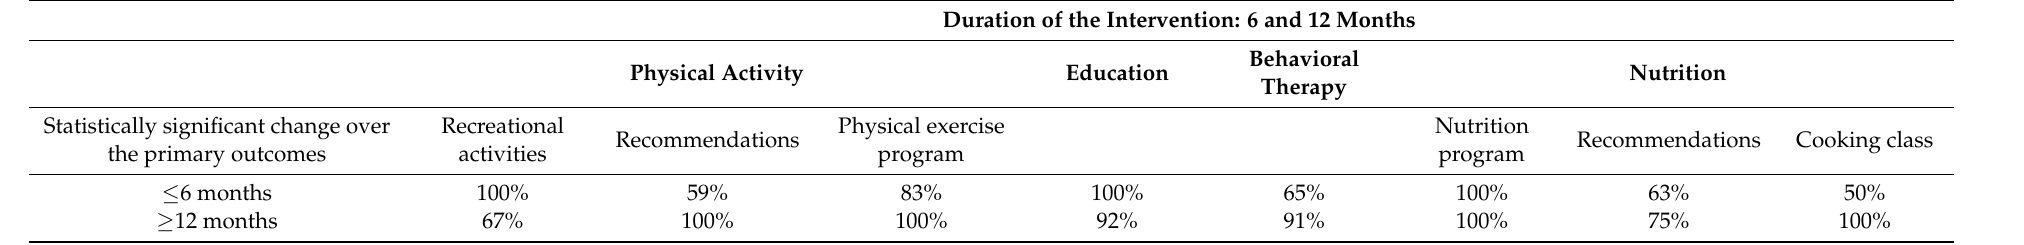
Table 4. Statistically significant effects of the interventions lasting 6, and 12